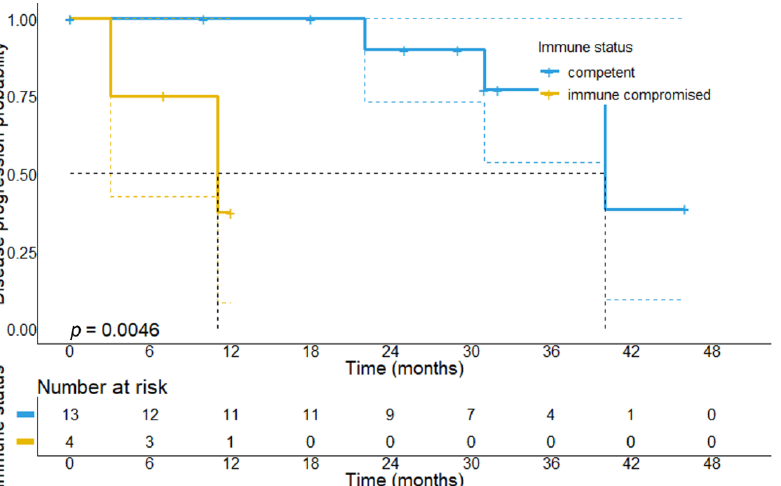
Figure 4. Progression-free survival in patients who achieved response to first-line CPI treatment stratified by the immune status. It can be found that immunocompromised responders have a significantly shorter PFS (11 months, 95% CI: 0–23.0 months vs. 40 months, 95% CI: 27.1–52.9 months, p = 0.0046) as compared to immunocompetent patients, which suggests that responses in immunocompromised patients are short-lived, whereas immunocompetent patients achieve more durable responses.